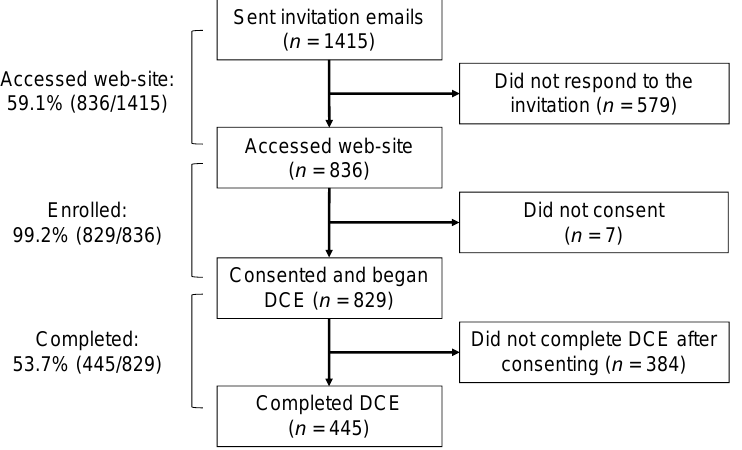
Figure 2. Flow diagram. DCE — discrete choice experiment. Table 2. Participants’ characteristics.